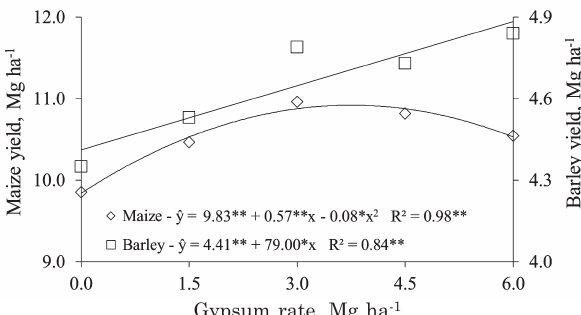
Figure 5. Yield of maize and barley at 2009-2010 and 2010 harvests as a function of gypsum rates applied on the soil surface under a no-till system. * p<0.05 and **